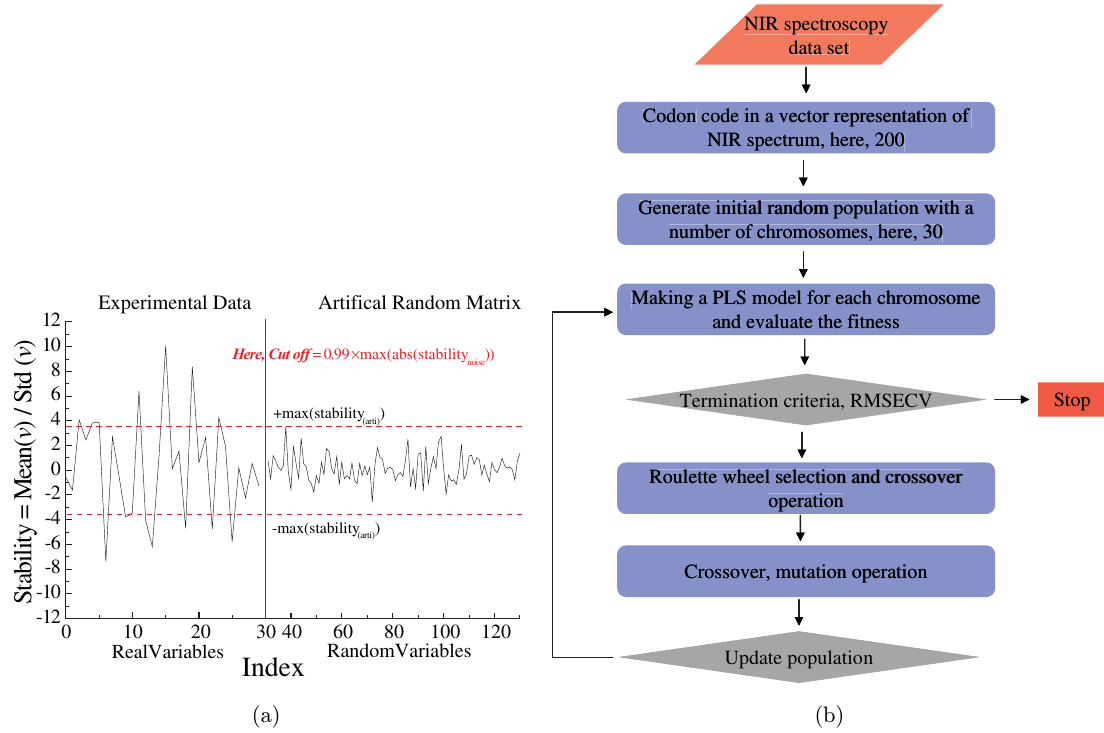
Fig. 1. Schematic diagrams for (a) the mechanism of UVE algorithm and (b) the operation process of